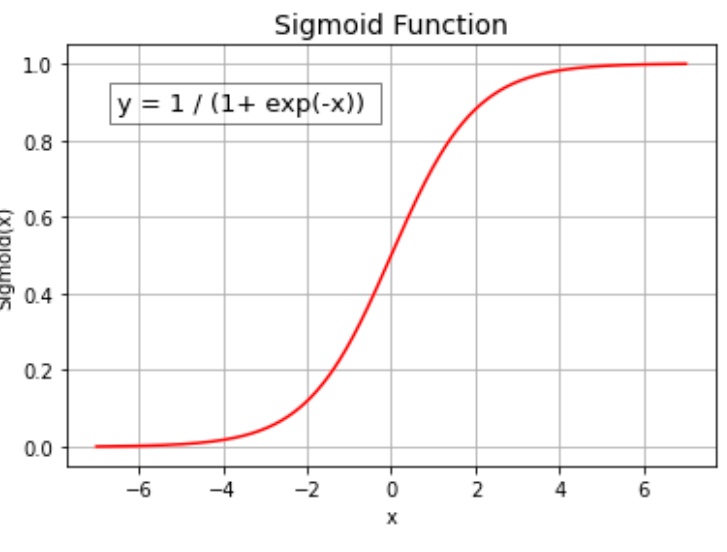
Figure 3. Sigmoid Function.